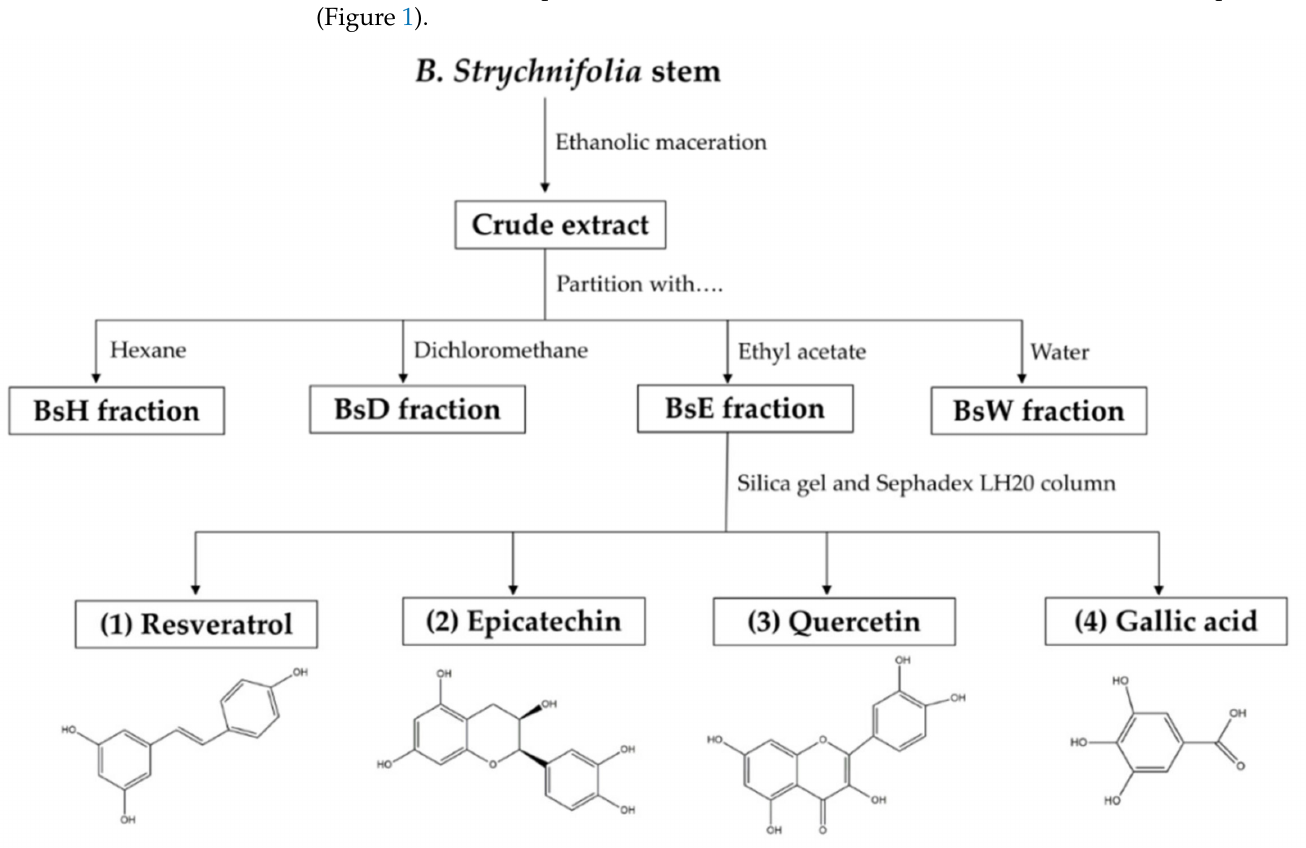
Figure 1. Schematic procedure of extraction, fractionation, and isolation of B. strychnifolia stem, as well as the chemical structures of compounds, which were isolated from the BsE